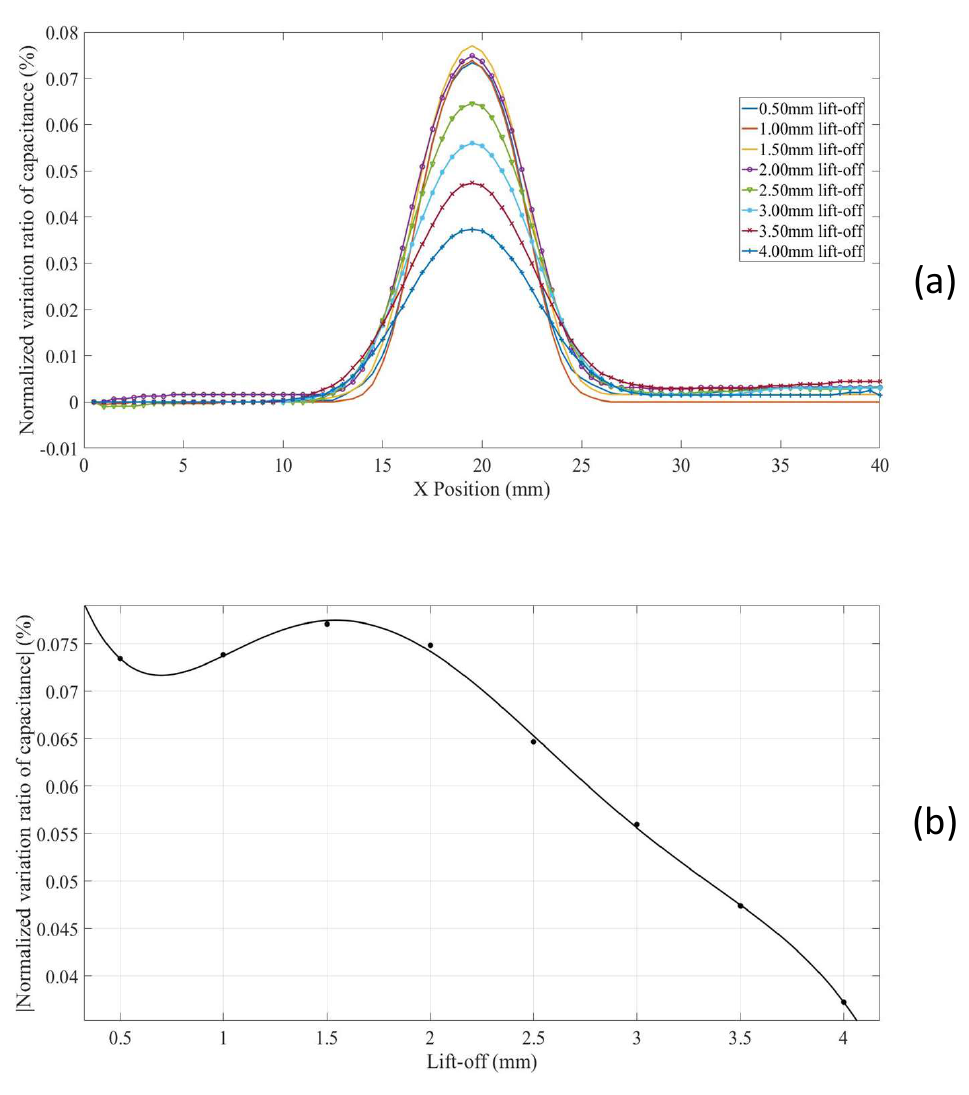
Figure 21. ( a ) NVR curves for the surface 3 mm hole on specimen II (grounded) with lift-offs increased from 0.5 mm to 4 mm ( b ) absolute values of the NVRs at the centre point against lift-offs.